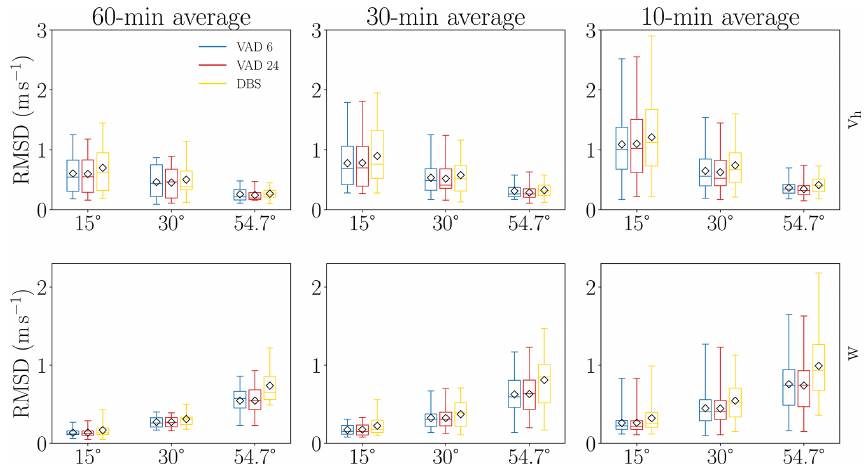
Figure 10. Ensemble case 4: RMSD of virtual lidar measurements of horizontal and vertical wind with reference to the respective “true” wind profile above the lidar. RMSD values were calculated over a height interval extending from 50 to 960m for measurements averaged over different time intervals. Results are grouped by zenith angle configuration (15, 30 and 54.7 ◦ ). Different colors denote different scan techniques (VAD 6, VAD 24 and DBS). Whiskers indicate the entire range of values, including the maximum and minimum. In addition, mean values are marked by a black